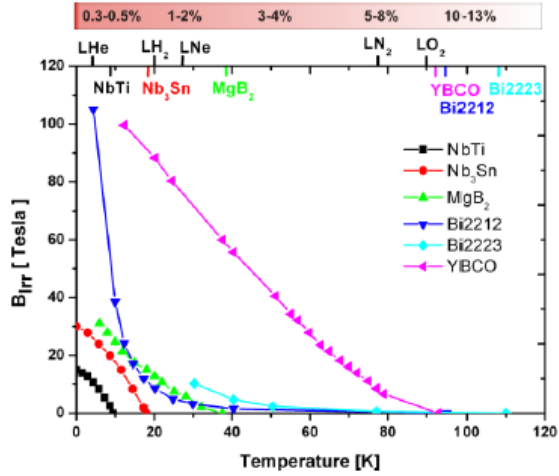
Fig.6 Operation boundaries of different superconductors, where the critical current vanishes. The top bar indicated the typical efficiency of a cryogenic cooling system. Reproduced